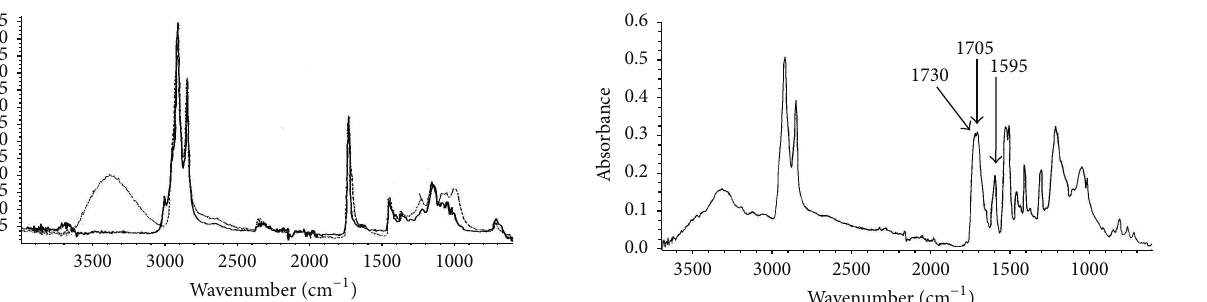
Figure 2: FTIR spectrum for biorenewable polymer of waste vegetable oil-based